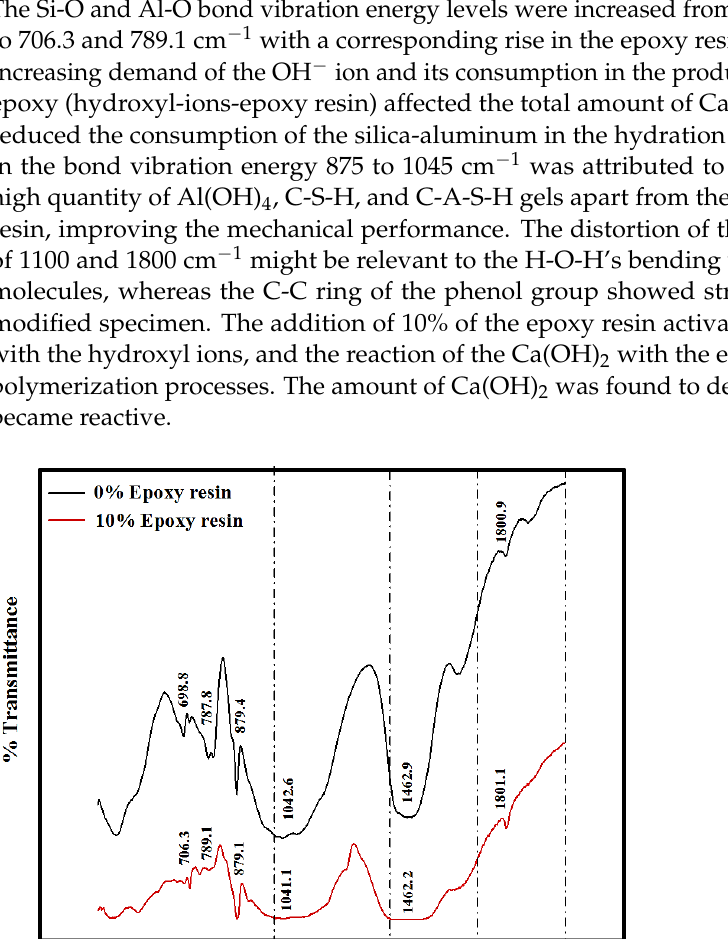
Figure 9. SEM micrographs of the ( a ) control and ( b ) 10% epoxy based mortar.